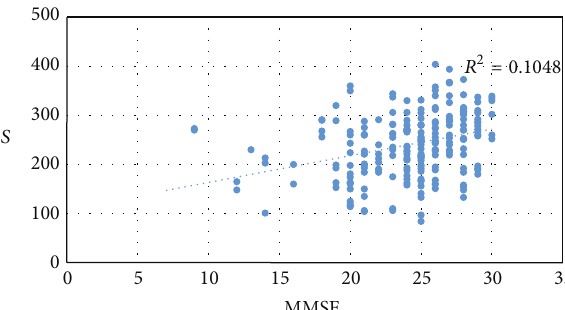
Figure 3: This figure shows that correlation between MMSE scores and subfoveal choroidal